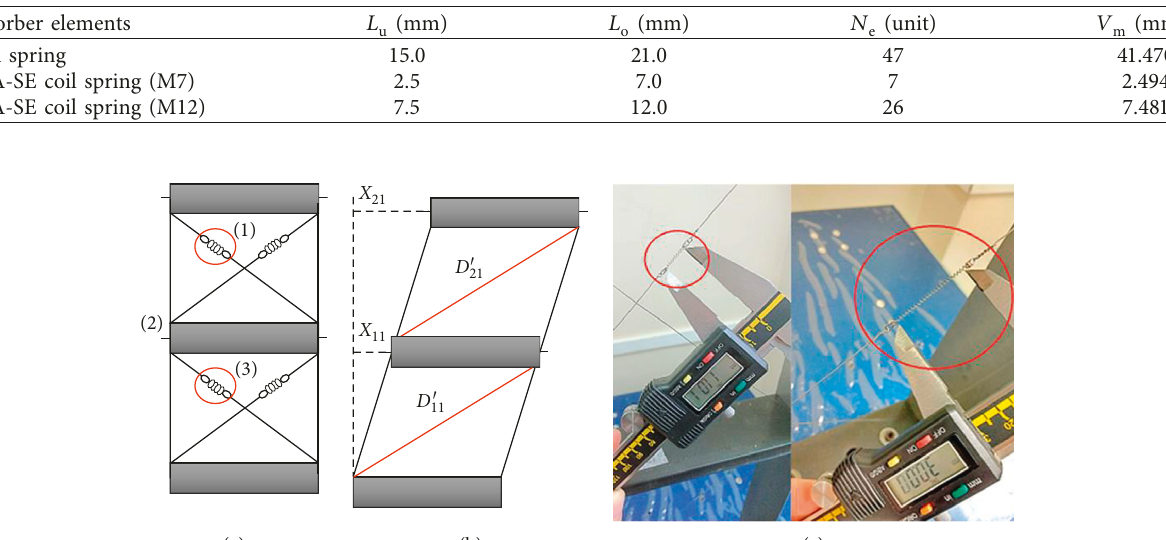
Figure 5: Absorber elements. (a) Springs used in the study and (b) length between eyelets and useful of the SMA-SE coil spring Table 2: Dimensional parameters of the absorber elements.